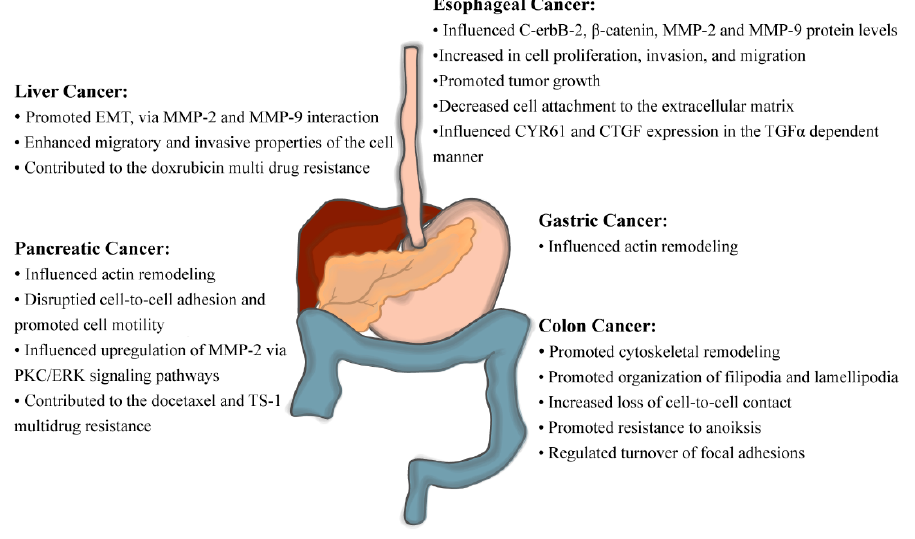
Figure 4. Fascin-1-associated cellular changes that promote GI tract carcinogenesis. These observa- tions were made via fascin-1 loss-of-function or gain-of-function experiments.